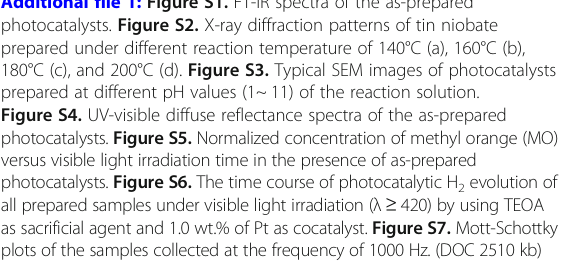
Additional file 1: Figure S1. FT-IR spectra of the as-prepared photocatalysts. Figure S2. X-ray diffraction patterns of tin